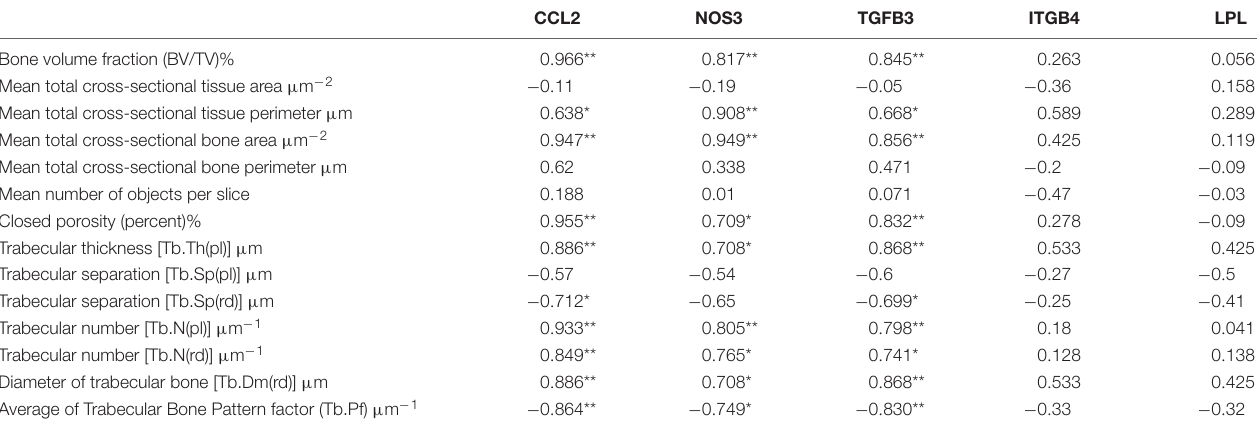
TABLE 6 | The correlation between key different genes and distal femur